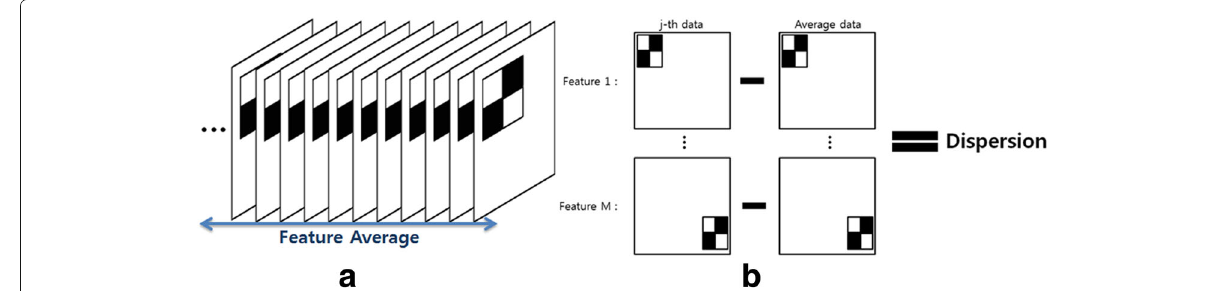
Fig. 4 Feature average ( a ) and data dispersion ( b